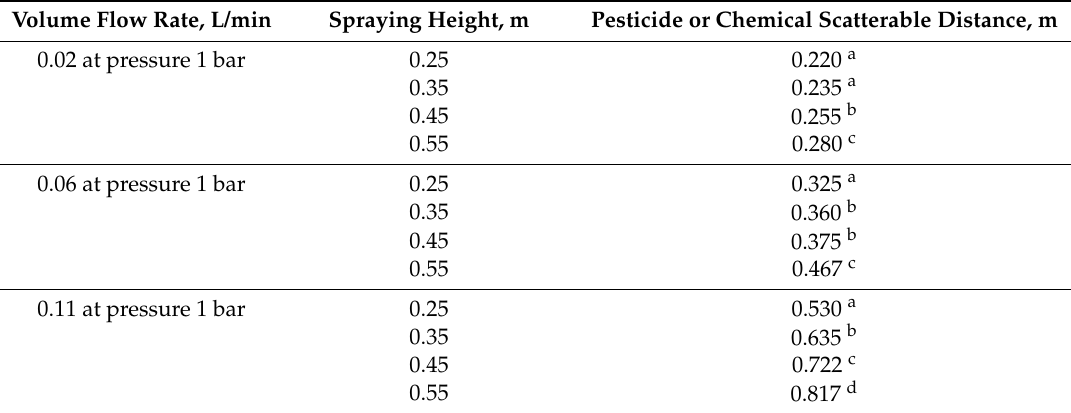
Table 3. Effect of spraying height on spray application.